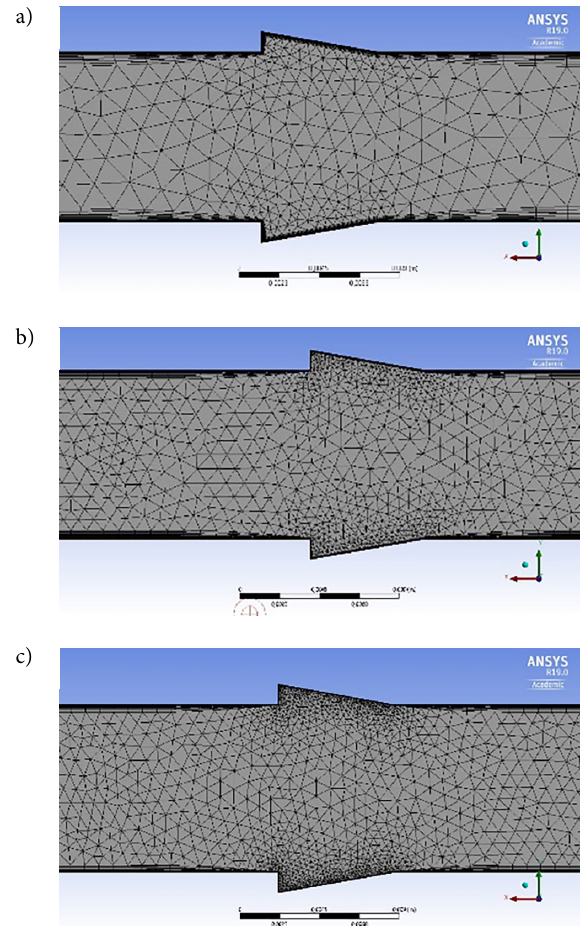
Table 5. The results of the mesh independency study